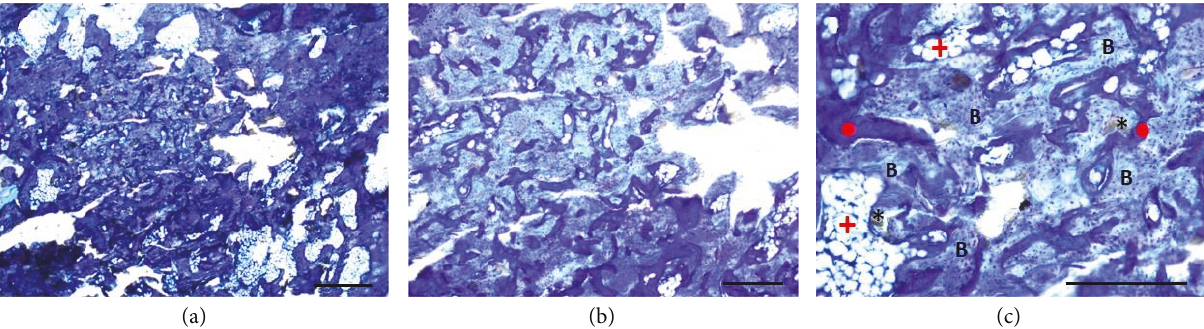
Figure 6: Photomicrographs of histological sections stained with toluidine blue taken from the hMSC-TCP group (a – c). (a) Almost complete bone defect regeneration (scale bar: 1000 μ m). (b) Newly formed bone showed disorganized and anastomosed trabeculae. TCP granules were osteointegrated (scale bar: 500 μ m). (c) TCP granules were surrounded by newly formed trabecular bone ( B ). Not completely osteointegrated TCP granules ( ∗ ) were in contact with adipose bone marrow (red plus sign) or connective tissue (red circle) at their bone-free surface. Normal osteocytes were present at the regenerated trabecular bone (scale bar: 500 μ m).